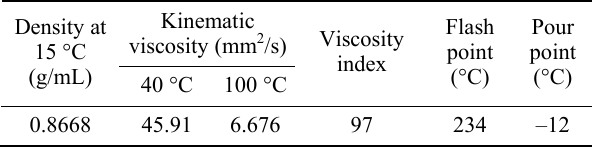
Table 1 Properties of MO used in this study.